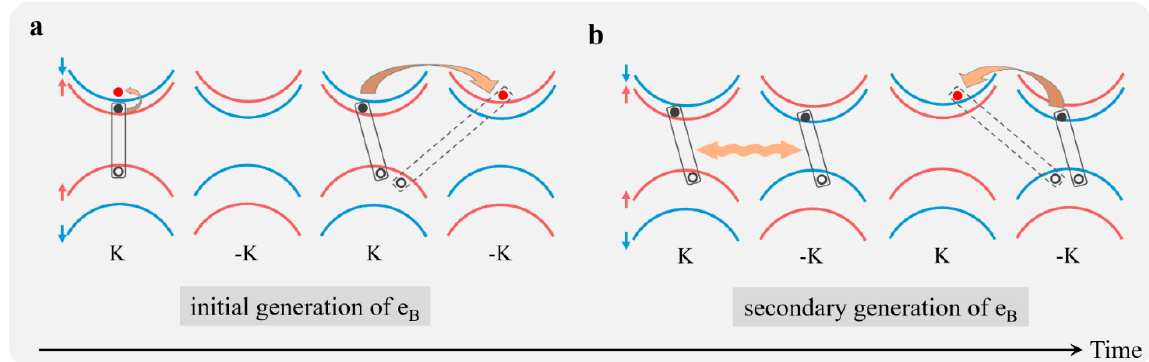
Figure 14. Phenomenological illustration of anomalous pump-probe signal of B-exciton resonance with excitation at A-exciton resonance. ( a ) Intravalley spin flip and direct exciton-phonon scattering give rise to the initial generation of pump-probe signal. ( b ) The secondary rising of pump-probe signal at B-exciton resonance results from intervalley exchange of A-exciton within valley lifetime and subsequent exciton-phonon scattering. Red (blue) arrows: spin up (down). e B , conduction band electron contributing to pump-probe signal of B-exciton resonance, marked in red.